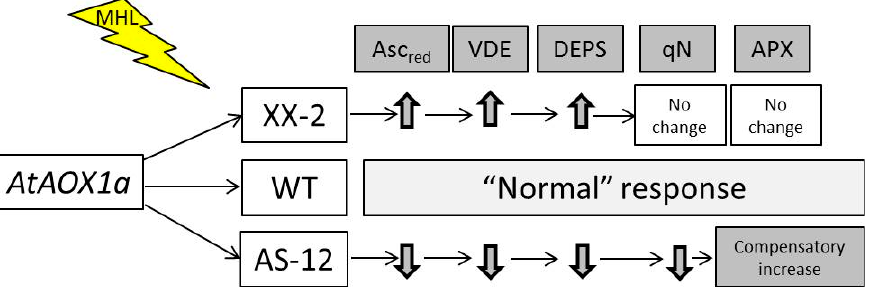
Figure 11. Physiological response of AOX1a -overexpression (XX-2) and AOX1a -antisense (AS-12) Arabidopsis thaliana plants versus the “normal” wild type (WT) response after 8 h of exposure to moderately high light (MHL). Asc red —relative levels of reduced ascorbate (from total pool of ascorbate), VDE—violaxanthin de-epoxidase content and gene expression, DEPS—level of de-epoxidation, qN—non-photochemical quenching, and APX—ascorbate peroxidase activity. Down and up bold arrows indicate a decrease and increase in a parameter, respectively. Arrows to the right indicate the possible sequence of events in the cell at different levels of AOX1a expression. See the text for further explanation.